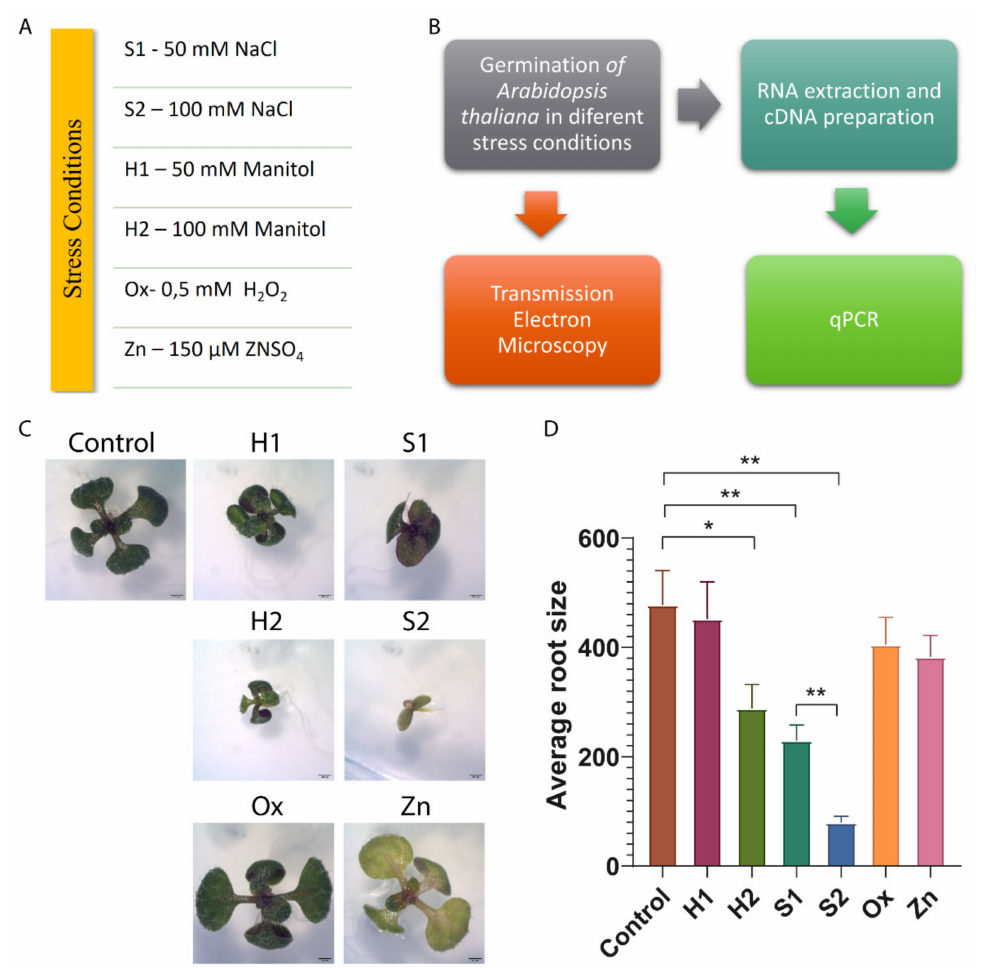
Figure 1. Arabidopsis thaliana seedling growth conditions, workflow schematic and biometric analysis. ( A ) Medium conditions used to induce stress: S1—salt stress, low concentration; S2—salt